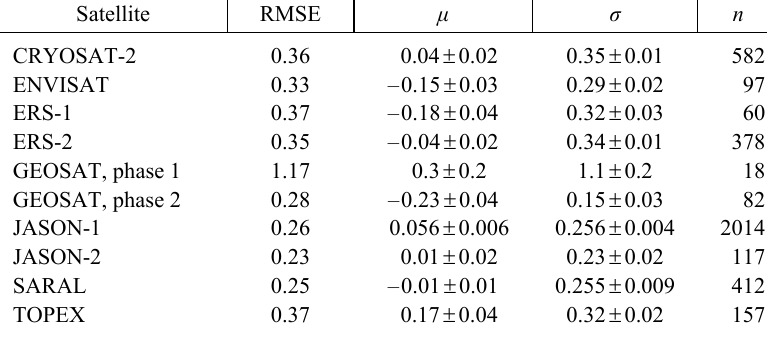
Table 3. Statistical properties (RMSE, mean μ , standard deviation σ of a fitted normal distribution and the number of data points n ) of cross-matches between satellite altimetry and in situ data. All quantities are presented in metres Satellite